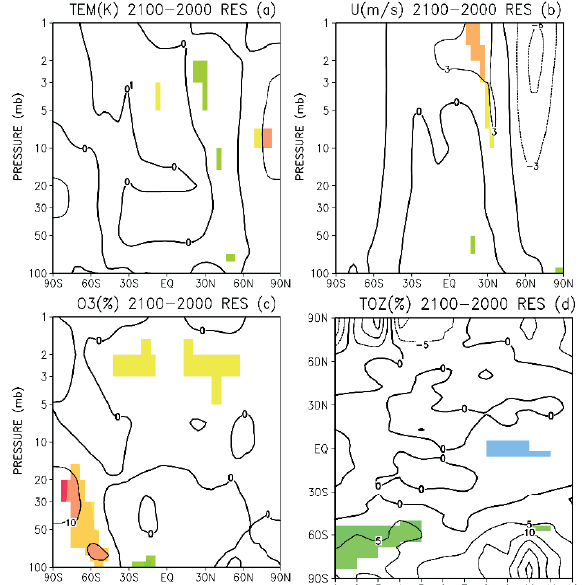
Fig. 6. Zonal and ensemble mean changes of annual mean zonal wind (ms − 1 ): (a) from 2000 to 2050; (b) from 2050 to 2100 and total column ozone (%): (c) from 2000 to 2050; (d) from 2050 to 2100. Color pattern indicates the regions where the changes are judged statistically significant at or better than 5% level. Positive changes are shown in reddish colors while small or negative changes are colored in